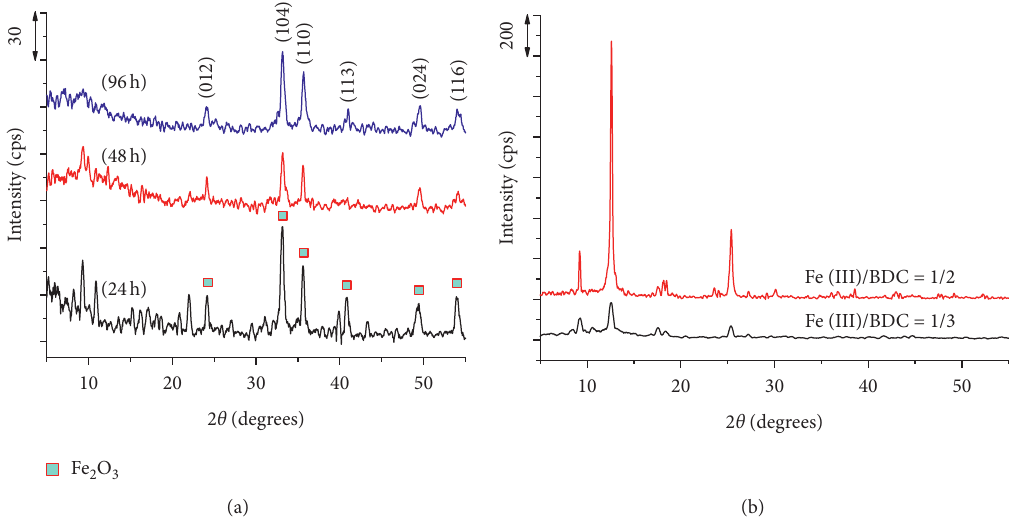
Figure 6: XRD patterns of iron (III) benzene dicarboxylate samples synthesized at 150 ° C: (a) different reaction times; (b) different molar ratios of Fe (III)/BDC (reaction time of